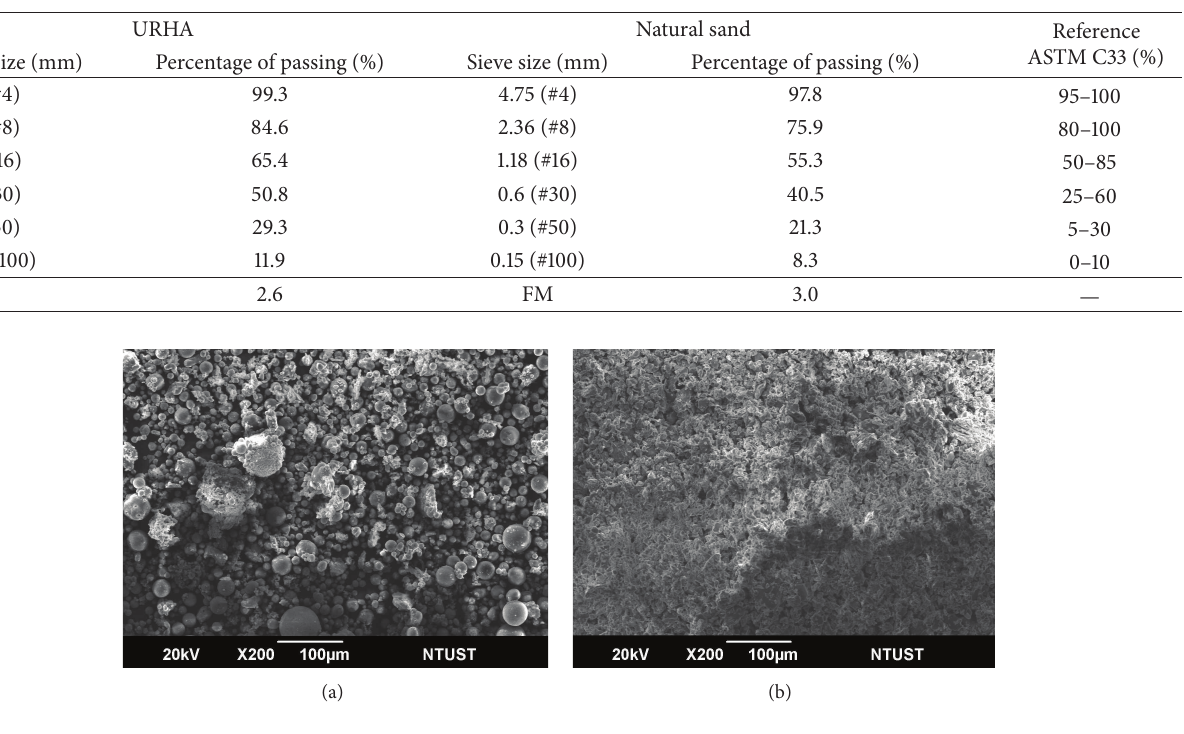
Figure 3: SEM images of (a) FA and (b) RHA particles.